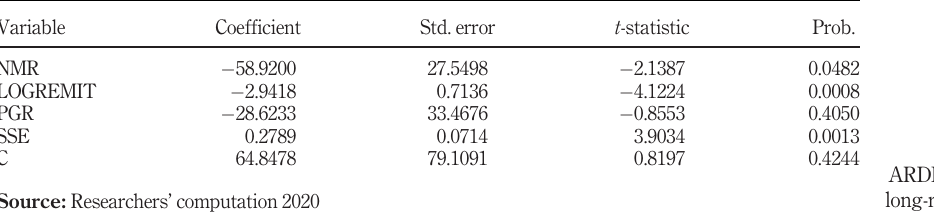
Table 6. ARDL estimation